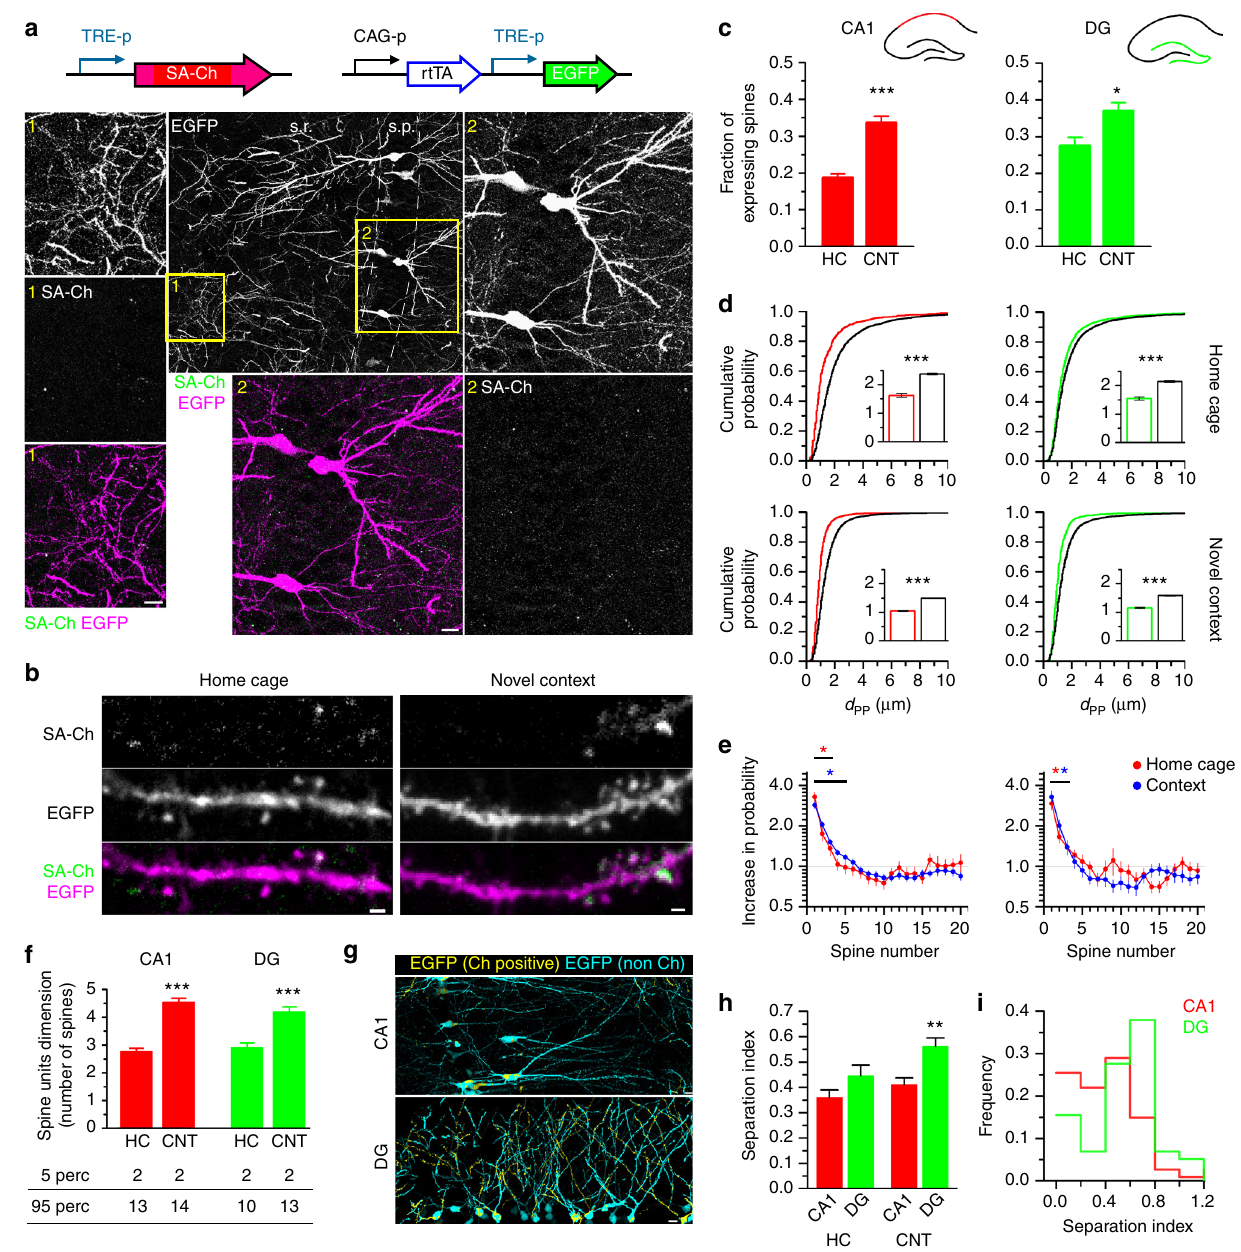
Fig. 5 In vivo synaptic tagging. a Constructs expressed in the hippocampus of electroporated mice. TRE-p is the tetracycline-responsive promoter. Expression of SA-Ch in mouse CA1 after 2d intraperitoneal doxycycline injection. Dendritic (1) and somatic (2) regions (yellow squares in the large- fi eld image) are magni fi ed, showing EGFP, SA-Ch, and merge channels (SA-Ch: green, EGFP: magenta). s.p. stratum pyramidale, s.r. stratum radiatum. b Dendrites expressing SA-Ch in pyramidal neurons in CA1 from animals held in the home cage or exposed to a novel context (see text). c Average fractions of SA-Ch-positive spines in CA1 and DG neurons in home cage (HC) and novel context (CNT) groups. * P < 0.05, *** P < 0.001, Student ’ s t -test, two-tailed. d Distribution of fi rst neighbor distance ( d PP ) for two potentiated spines in CA1 (left) and in the DG (right). Graphs on the top represent data from home-caged animals, bottom graphs from animals exposed to a novel context. Black lines are the corresponding distributions after randomly shuf fl ing positive/negative assignments to the original spine positions. Insets show, with corresponding colors, fi rst neighbor distance mean ± SEM. *** P < 0.001 Kruskal – Wallis test, followed by Dunn ’ s comparison. e Measured increase in estimated probability to be potentiated themselves for the fi rst 20 neighbors of a potentiated spines in CA1 (left panel) and DG (right panel) neurons. Under the assumption of random distribution of potentiated spines, this value should be 1 uniformly. * P < 0.01, z -test from the reference value of 1. Points are mean ± SEM. f Mean number of spines per unit (cluster and single spines). Bottom table represents the 5th and 95th percentiles of cluster dimension. *** P < 0.001 Kruskal – Wallis test, Dunn ’ s comparison. Bars are mean ± SEM. g Localization of SA-Ch-positive regions (yellow) and SA-Ch-negative region (cyan). Original images are in Supplementary Fig. 12. h Separation index (see text for details). A large separation index value indicates that the number of potentiated spine in the dendrite strongly deviates from the expected value if potentiated spines were equally distributed in neurons from the same slice. ** P < 0.01 Kruskal – Wallis test, Dunn ’ s comparison. i Separation index distribution of dendrites in CA1 and the DG in context-exposed animals. Scale bar, 10 μ m ( a , g ) and 1 μ m ( b